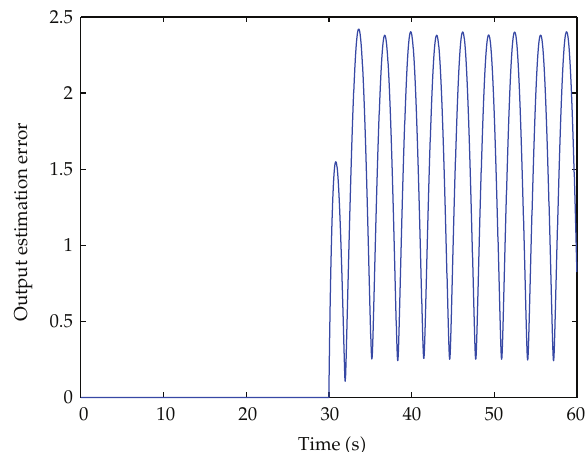
Figure 4: Output estimation error in case 2 using a low frequency disturbance.